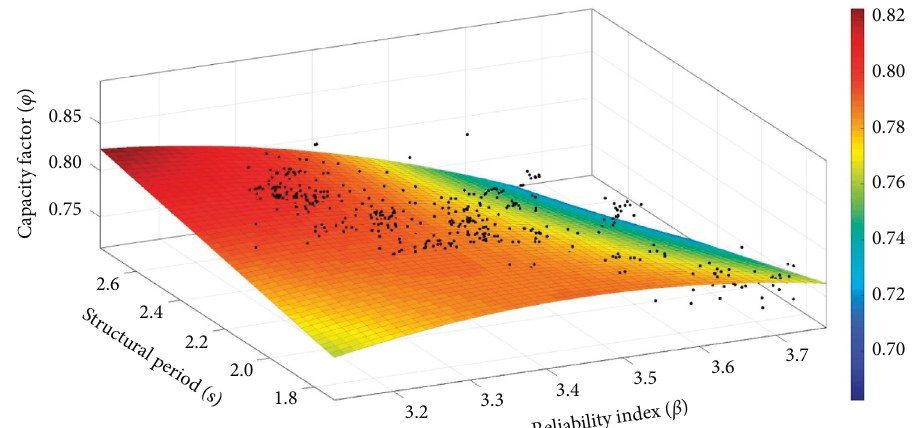
Figure 4: Capacity factor vs reliability index and structural vibration period.